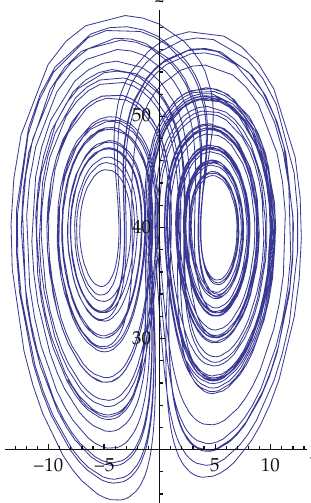
Figure 4: yz -phase portrait for α (cid:8) 0 . 98.